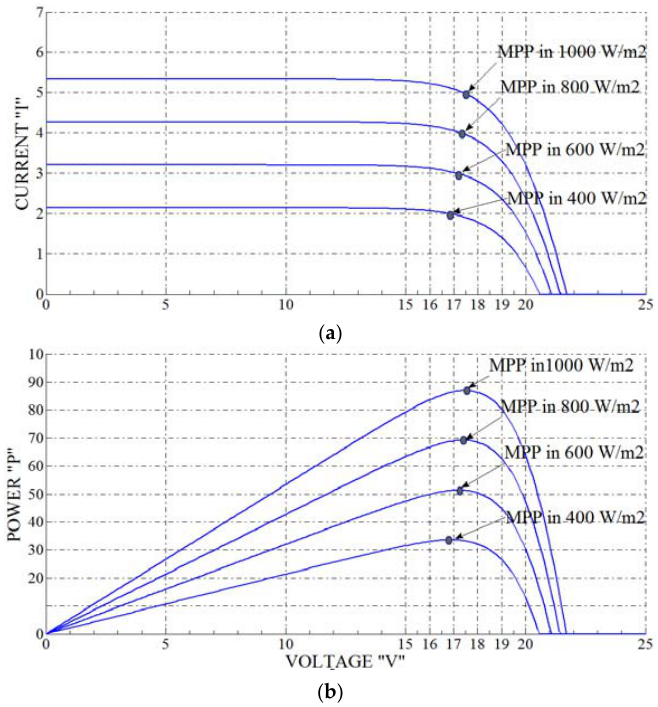
Figure 2. Output characteristic curves for the KC85T PV module for no ‐ shading conditions ( a ) Current–Voltage correlation curves and ( b ) Power–Voltage correlation curves [36].